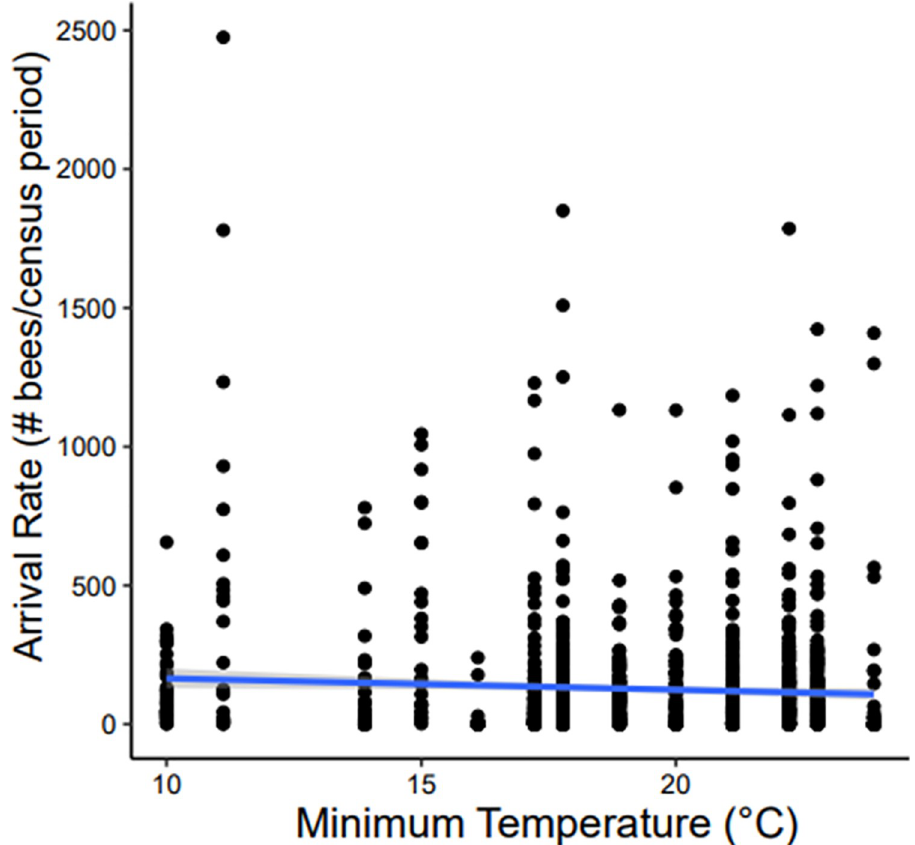
Fig 8. Relationship between minimum temperature and arrival rate. A regression between minimum daily temperature and bee arrival rates throughout the day are shown. There was no relationship between minimum temperature and bee arrivals, with high activity seen even during the coldest nights in winter ( P > 0.05). Data shown here includes all observations from all five focal colonies studied over the course of the